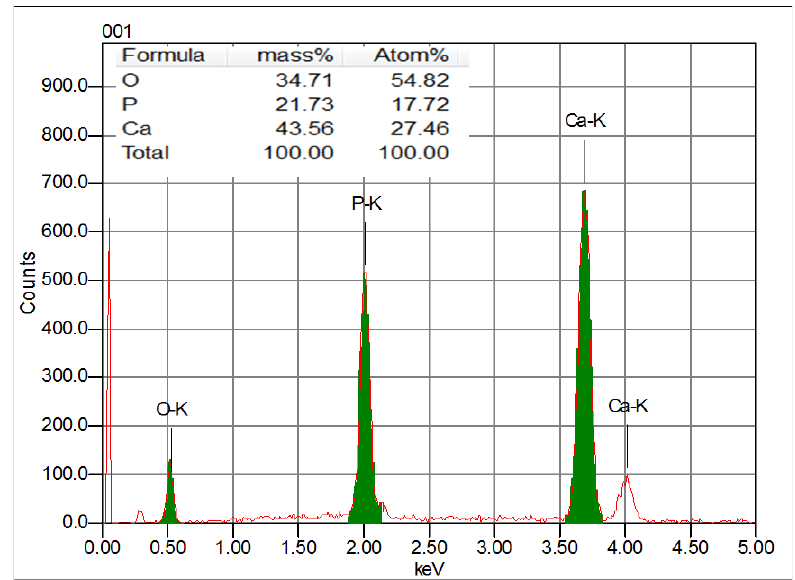
Figure 4. EDX spectrum of the synthesized HAp powder.